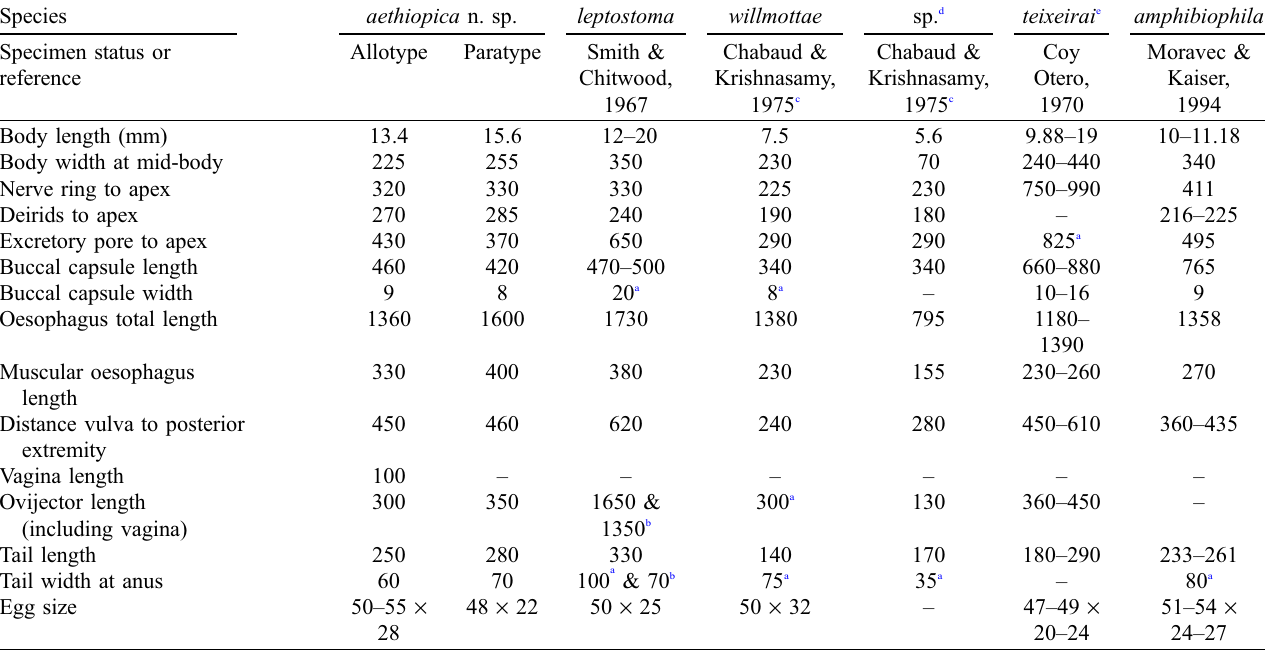
Table 2. Morphological characteristics of the females of Trichospirura aethiopica n. sp. from Malacomys longipes in Gabon and Trichospirura spp. aethiopica n.